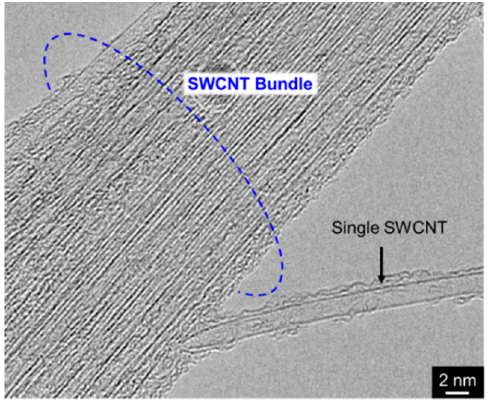
Figure 6. TEM image of SWCNT bundle.